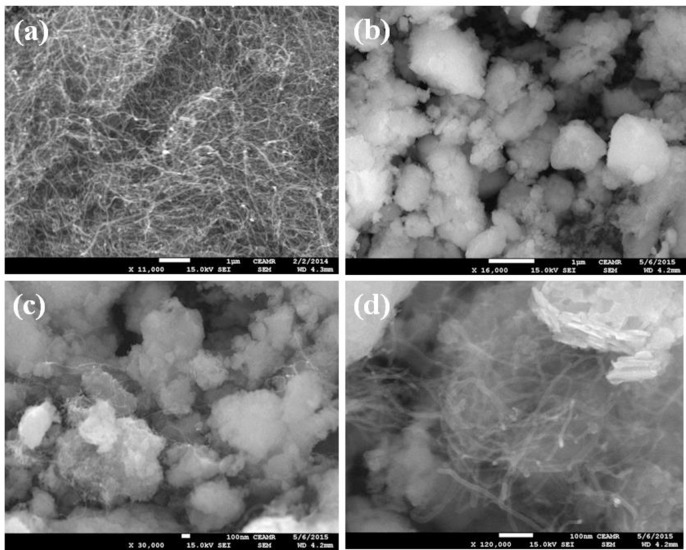
Magnified FESEM images, (a) CNT, (b) Ce2O3 NPs, and (c-d) Ce2O3.CNT NCs.